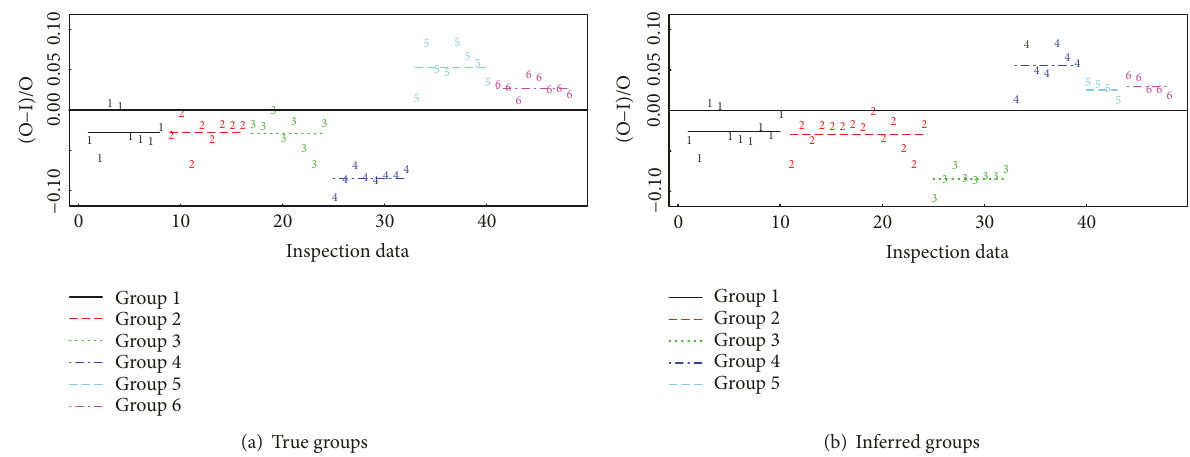
Figure 7: Example of change detection results using a sliding window and the MAD-based estimate of 𝛿 𝑅 . The simulated data had 𝑔 = 6 groups, each with 𝑛 = 8 observations, with 𝛿 𝑅 = .02, 𝛿 𝑆 = .06 .